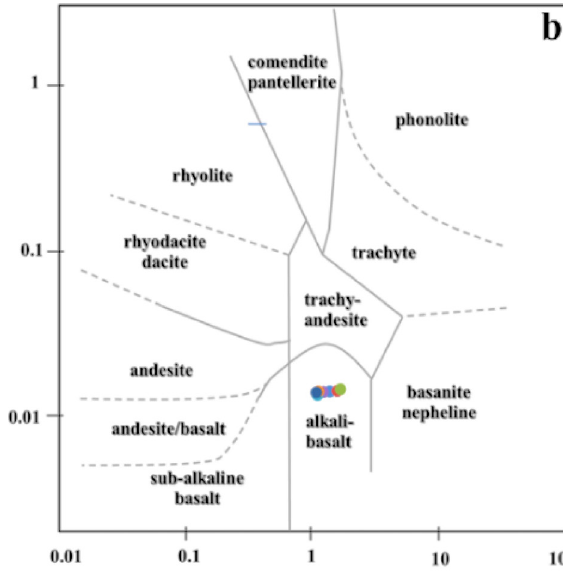
versus. Na O+ K O) and 2 2 2